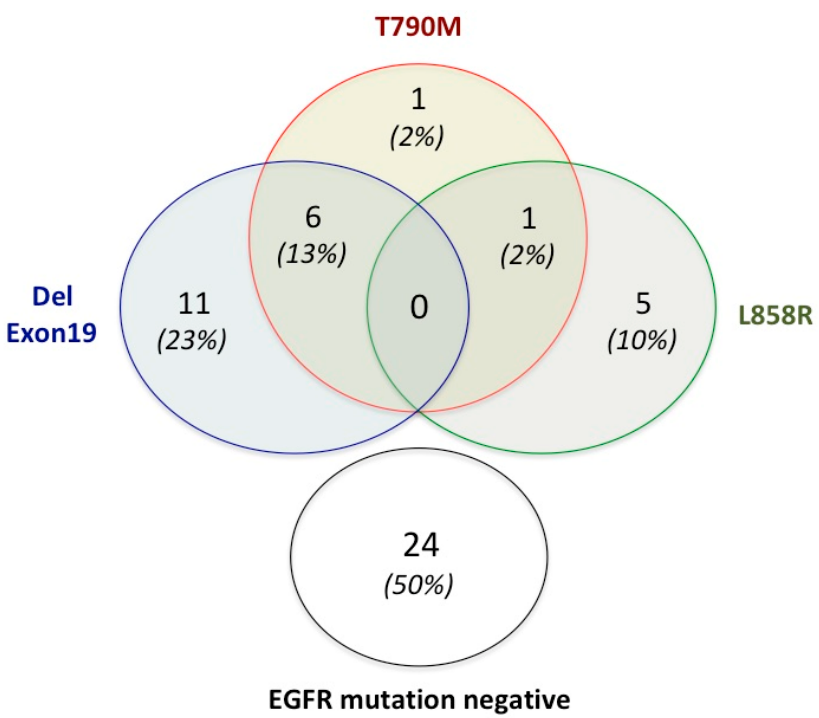
Figure 1. EGFR mutation status in ctDNA samples at the time of disease progression using the Therascreen ® assay. Number and percentages of the different subsets of patients (N = 48) are reported. Table 2. EGFR mutation status comparison between testing on primary tumour tissue with pyrose- quencing and on blood ctDNA at progression with Therascreen. EGFR Mutation